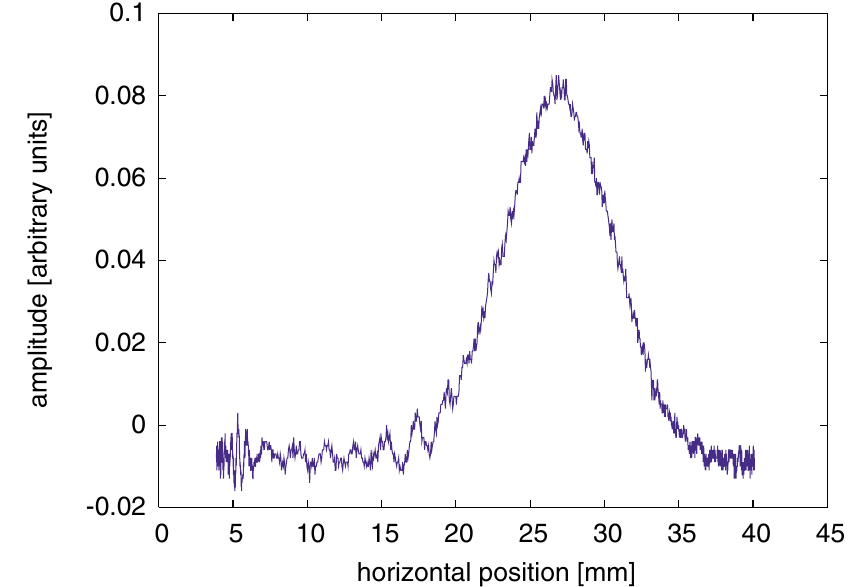
FIG. 4. (Color) Typical horizontal beam profile measured with the ‘‘flying beam’’